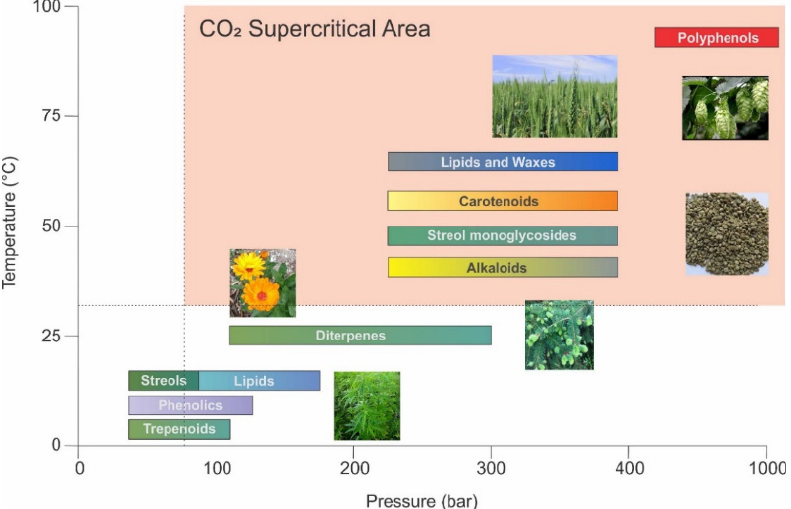
Figure 1. Schematic diagram showing control parameters of Supercritical Extraction (SCE) processes for the extraction of bioactive compounds.